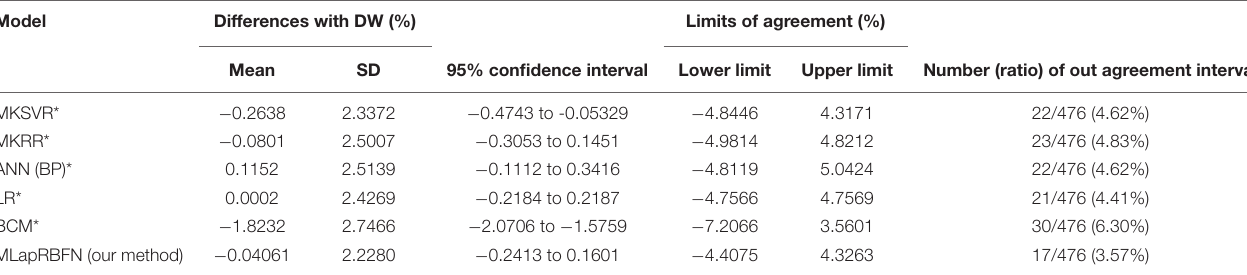
TABLE 3 | Bland–Altman plot analysis of the models.